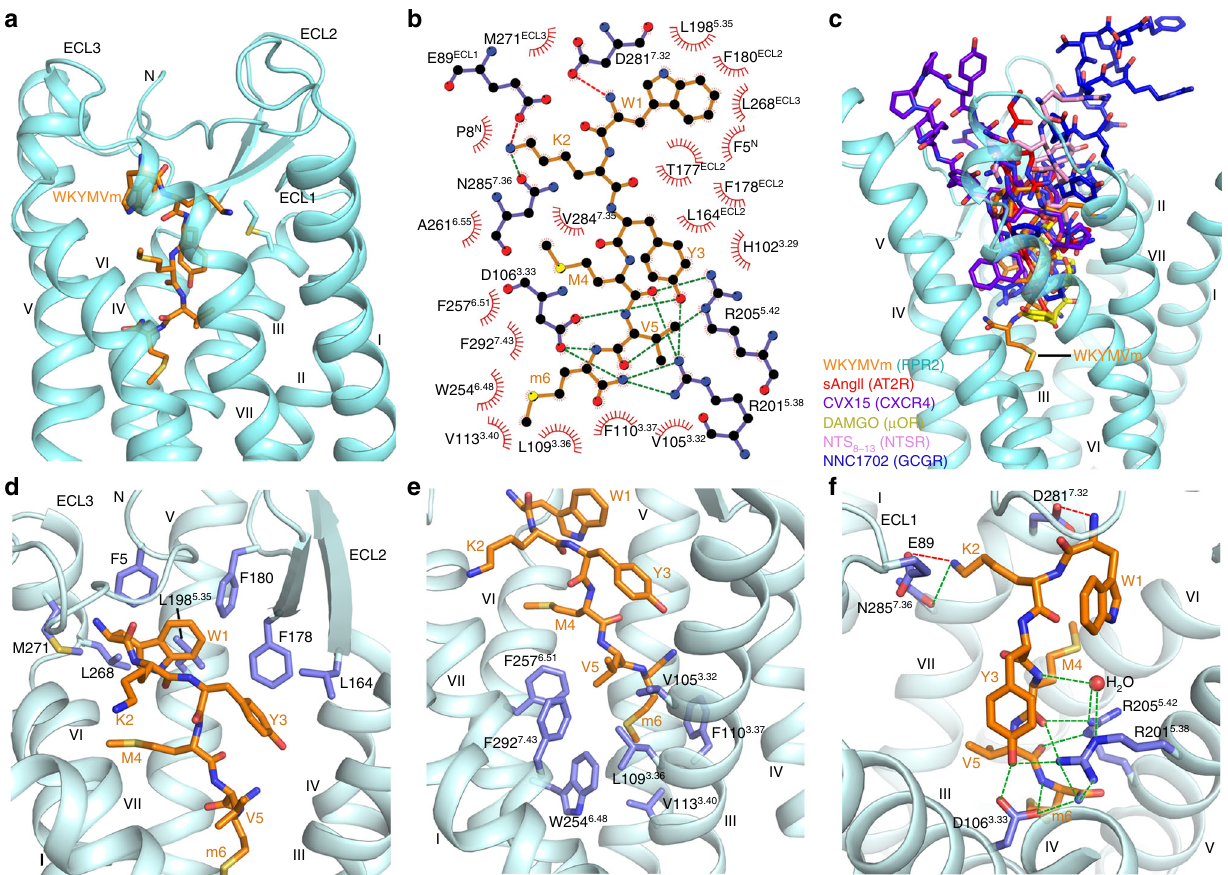
Fig. 3 Ligand binding mode of FPR2 to WKYMVm. a Binding pocket of WKYMVm in FPR2. The receptor in the FPR2-WKYMVm structure is shown in cyan cartoon representation. The ligand WKYMVm is shown as orange sticks. b Schematic representation of interactions between FPR2 and WKYMVm analyzed using the LigPlot + program 44 . Salt bridges and hydrogen bonds are shown as red and green dashed lines, respectively. The stick drawings of FPR2 and WKYMVm are colored blue and orange, respectively. c Comparison of the peptide ligand-binding sites in peptide-bound GPCR structures. WKYMVm in FPR2 (orange), sAngII in AT2R (red, PDB code: 5XJM), CVX15 in CXCR4 (purple, PDB code: 3OE0), DAMGO in μ OR (yellow, PDB code: 6DDF), NTS 8 – 13 in NTSR (pink, PDB code: 4GRV), and NNC1702 in GCGR (blue, PDB code: 5YQZ) are shown as sticks. Only the receptor in the FPR2-WKYMVm structure is shown in cyan cartoon representation for calri fi cation. d Hydrophobic cluster that forms interactions with W1 and Y3 of WKYMVm. The receptor residues and ligand are shown as blue and orange sticks, respectively. e Hydrophobic cluster that forms interactions with V5 and m6 of WKYMVm. f Polar interactions between FPR2 and WKYMVm. Salt bridges and hydrogen bonds are shown as red and green dashed lines,